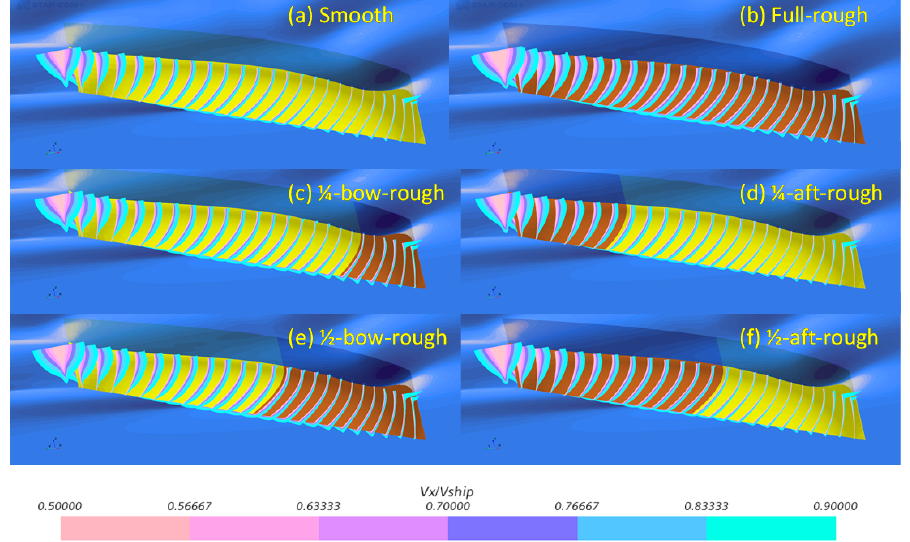
Figure 15. Boundary layer represented by slices limited to axial velocity ( V x / V ship = 0.9), Fr =